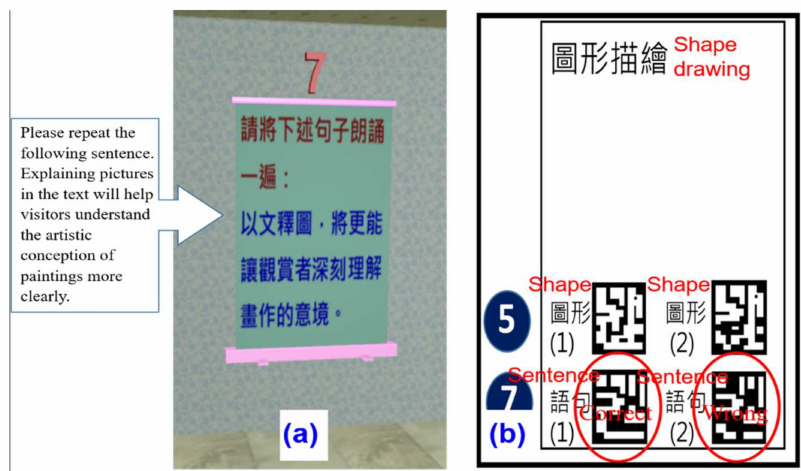
Figure 8. Language test screen: ( a ) Instructions screen for repeating a sentence (i.e., the blue words); ( b ) The repeated sentence needs to be confirmed by the tester. If correct, the “Sentence no. (2)” code should be scanned with the mobile phone.